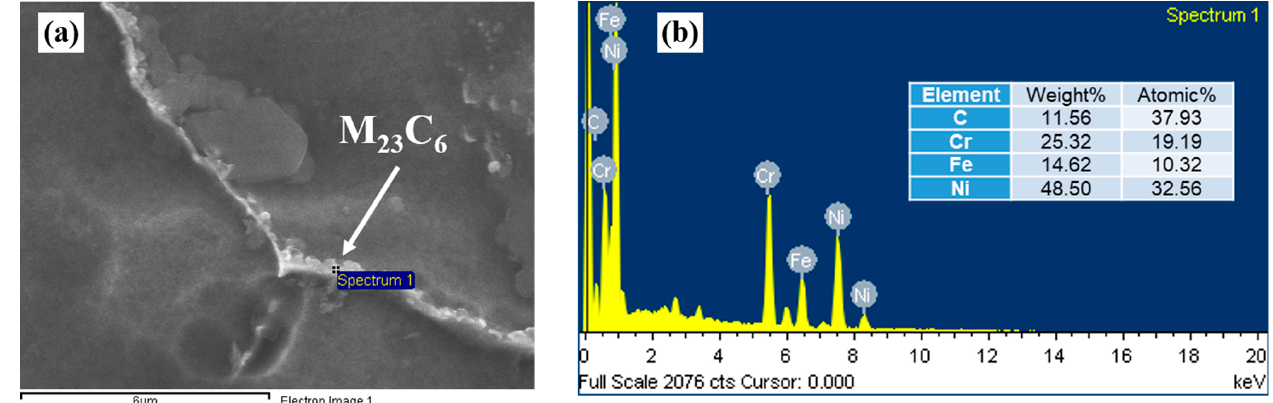
Figure 5. SEM micrographs and compositional analysis of M 23 C 6 : ( a ) M 23 C 6 precipitated on grains boundary; ( b ) EDS results of M 23 C 6 . boundary; ( b ) EDS results of M 23 C 6